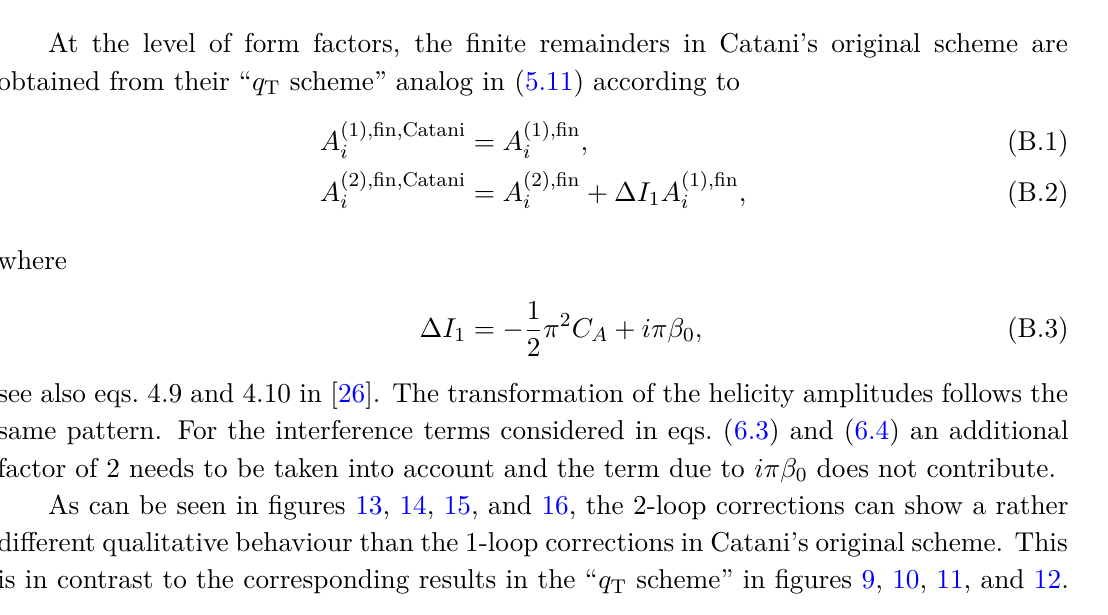
Figure 14. The cos( θ ) dependence of 1-loop and 2-loop interferences for polarised ZZ production √ in gluon fusion at s/m t = 1 . 426 . The large top-quark mass expansion [36] (to order 1 /m 12 shown for comparison. Here we reproduce the top left and bottom right panels of figure 10 using Catani’s original subtraction scheme